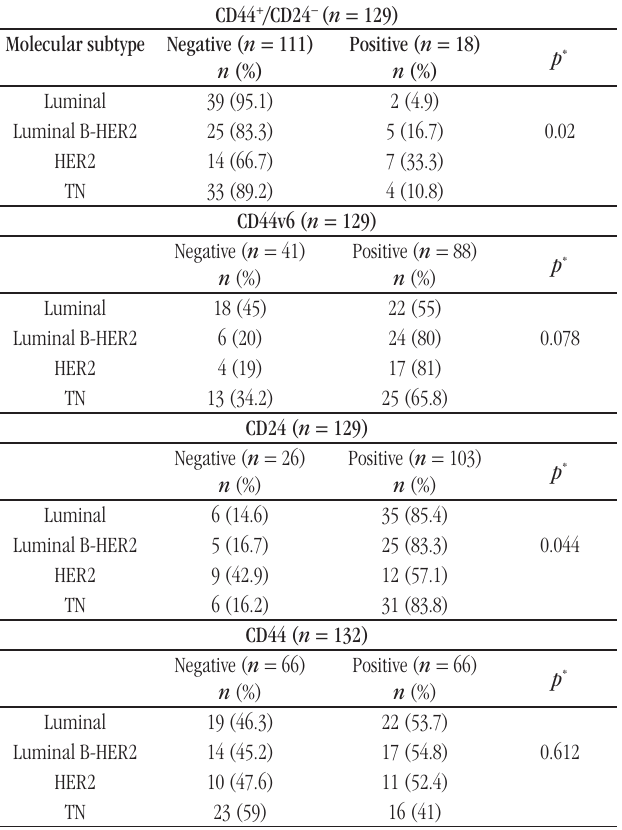
taBLE 6 − Comparison between molecular subtypes and CD44 and CD24